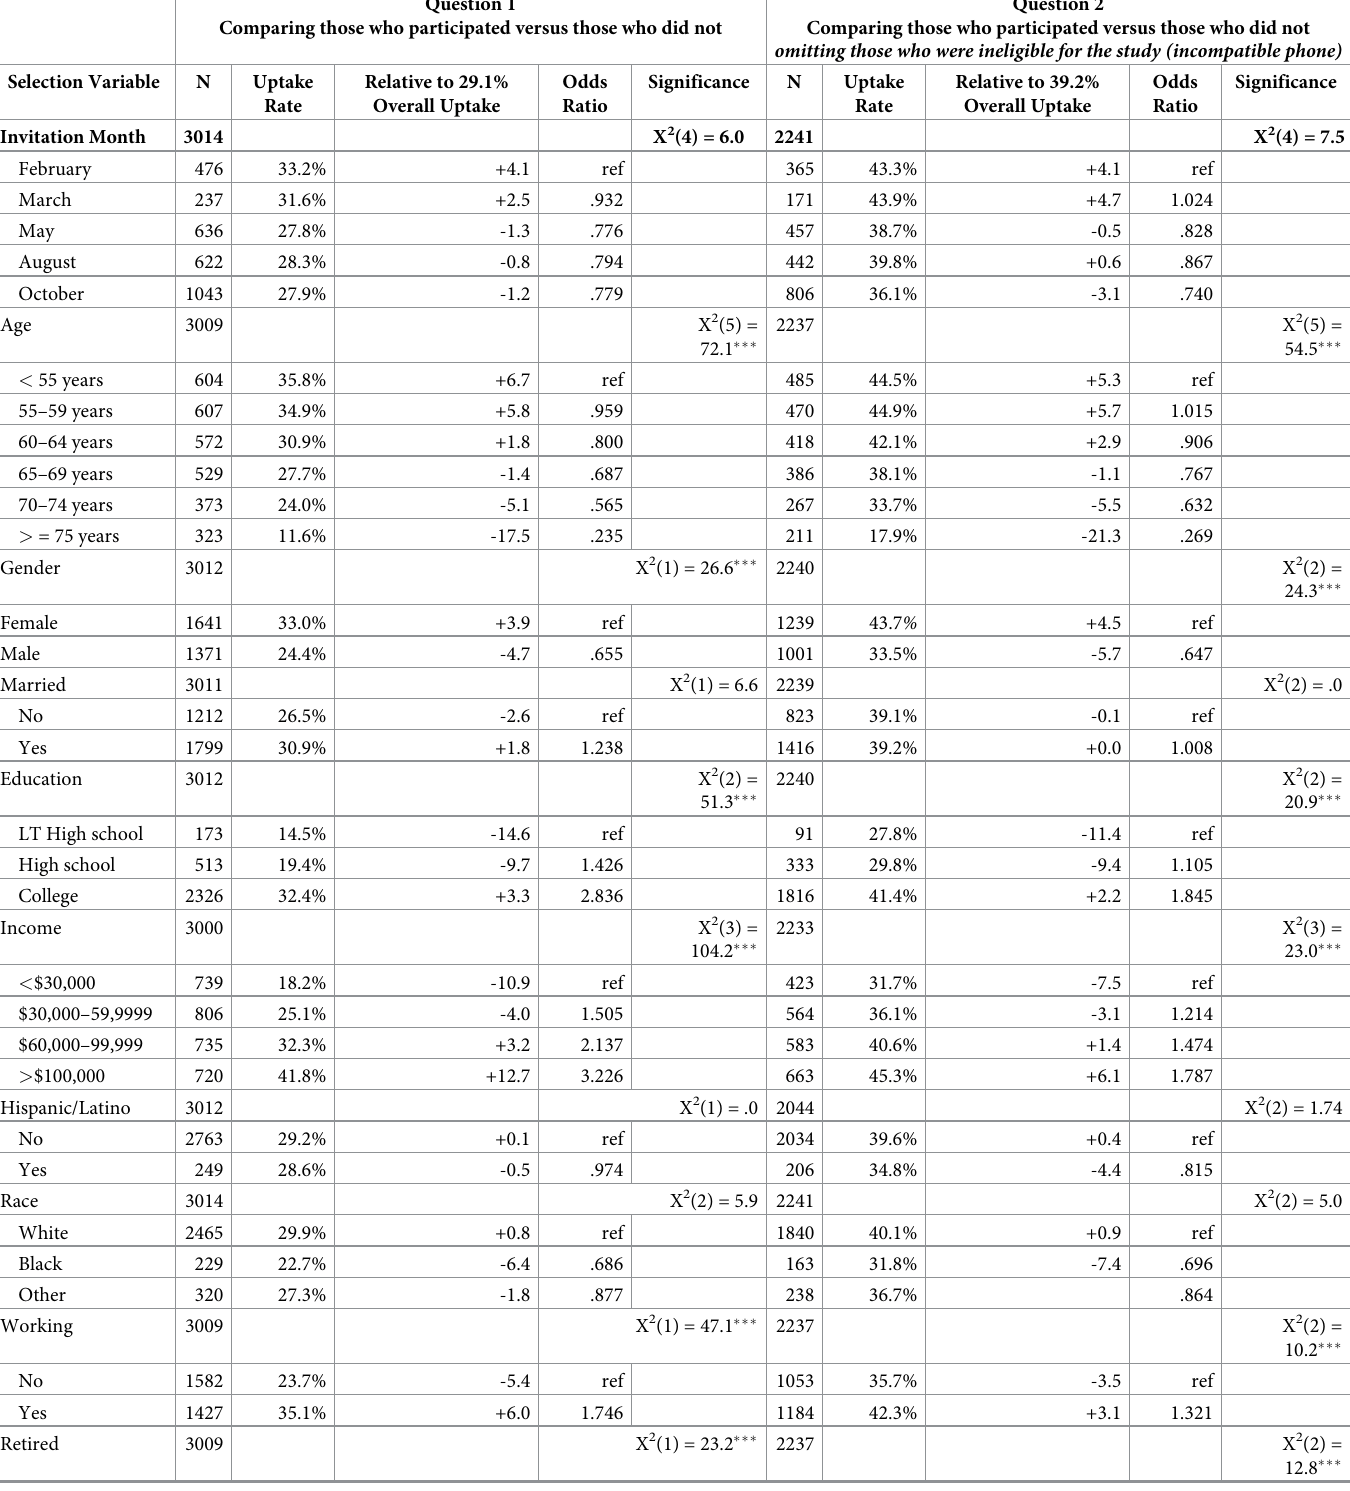
Table 1. Logistic regressions for each selection variable. Question 1 Question 2 Comparing those who participated versus those who did not Comparing those who participated versus those who did not omitting those who were ineligible for the study (incompatible